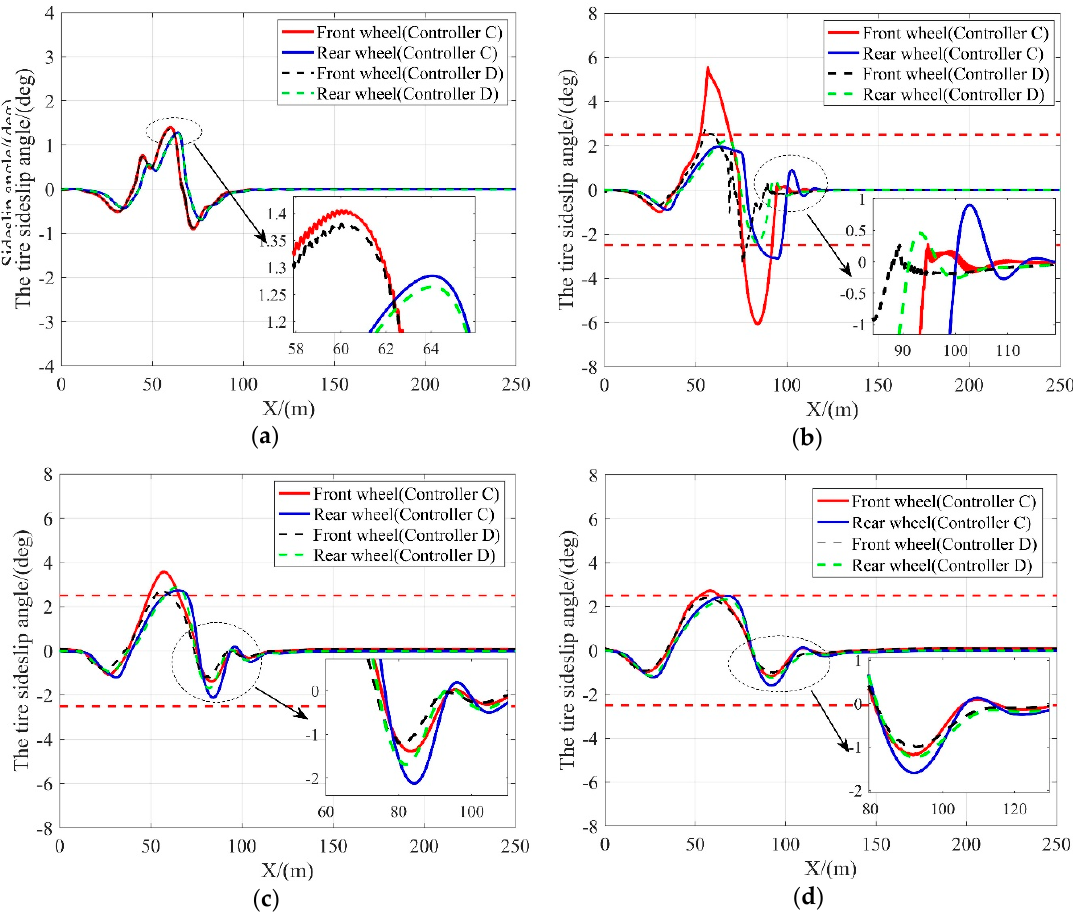
Figure 10. The desired and controlled steering angle of the front wheel with the controller C and D at different vehicle velocities. ( a ) 10 m/s; ( b ) 15 m/s; ( c ) 20 m/s; ( d ) 25 m/s.